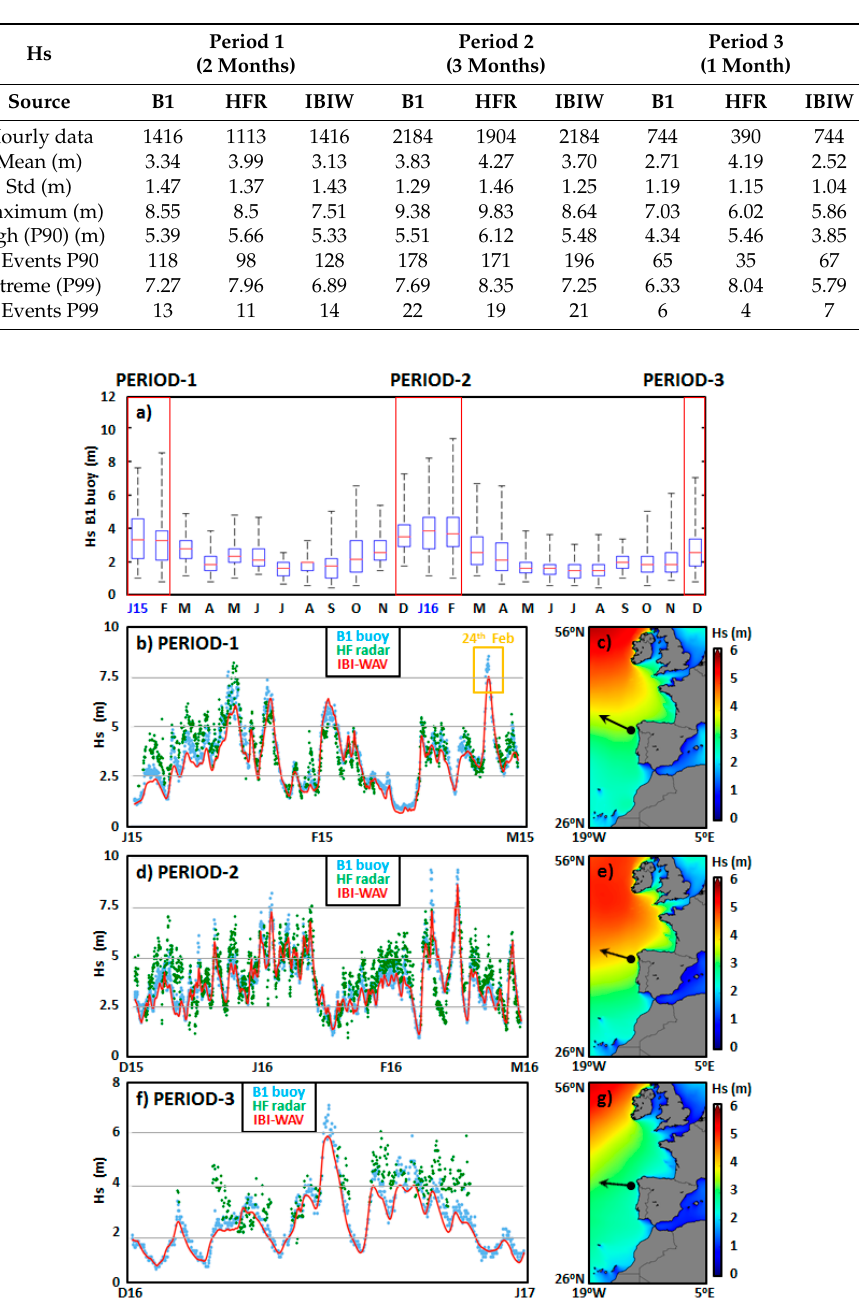
Figure 3. ( a ) Monthly boxplots of Hs registered at the B1 buoy for a two-year period (2015–2016). In each box, the central mark is the median, the edges of the box are the 25th and 75th percentiles, and the whiskers extend to the most extreme data points. Three periods of maximum Hs values have been selected (red boxes) ( b – g ) ( Left ) Time series of Hs estimations provided by the B1 buoy (blue dots), SILL radar site (green dots), and IBI-WAV (solid red line) for the three selected periods. ( Right ) Time-averaged Hs fields predicted by IBI-WAV for the three selected periods. Black filled dots represent the B1 buoy location.